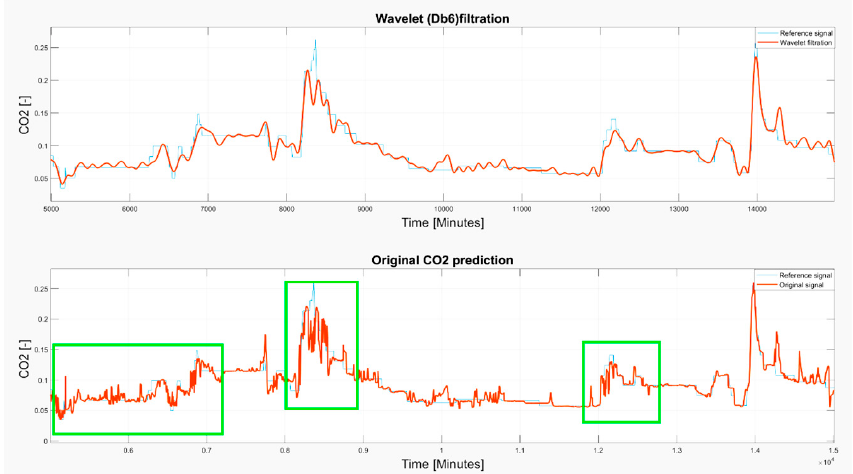
Figure 23. The 4 November–3 December 2018 prediction of the CO 2 signal containing several glitches and signal spikes, marked as green